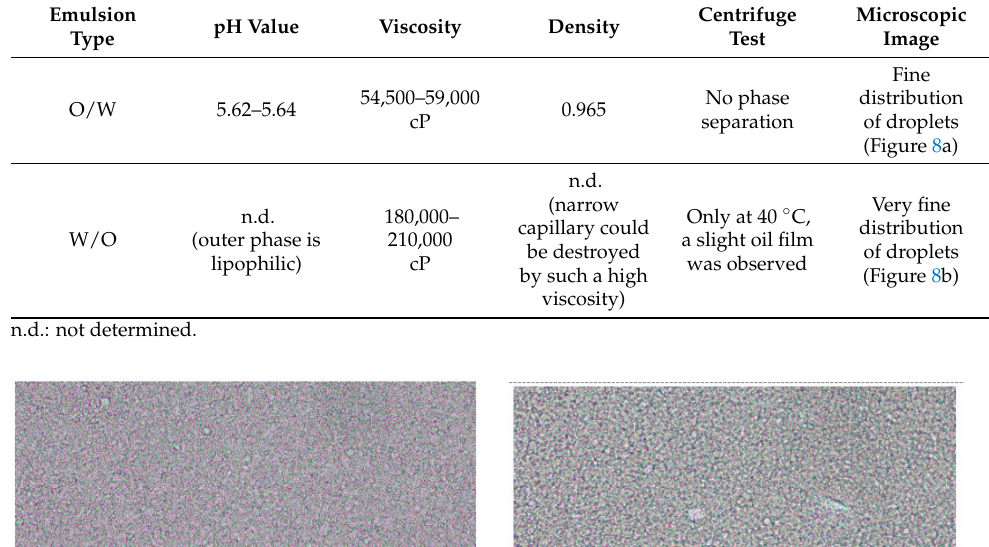
Table 1. Stability testing of the creams after 3 months storage time (results from the different storage conditions are within the reported ranges).